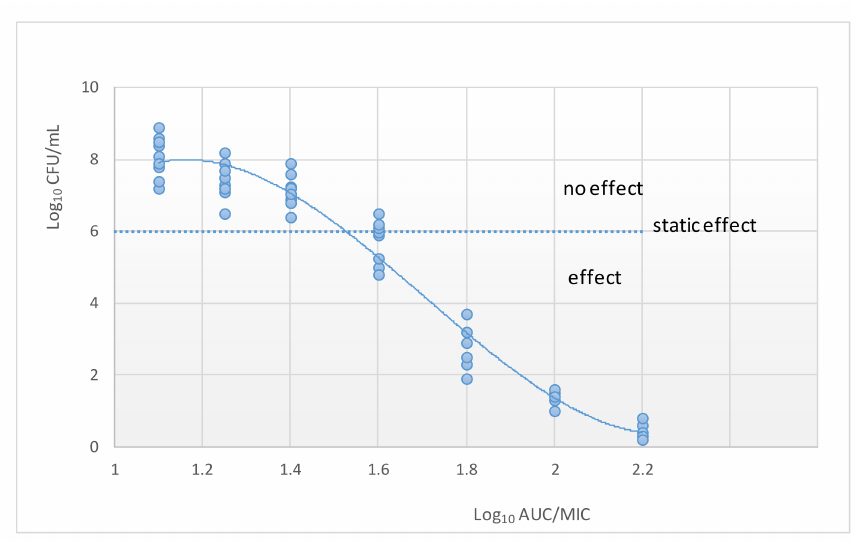
Figure 4. Relationship between the AUC and the number of colony-forming units (CUF). The dotted line indicates the initial inoculum.